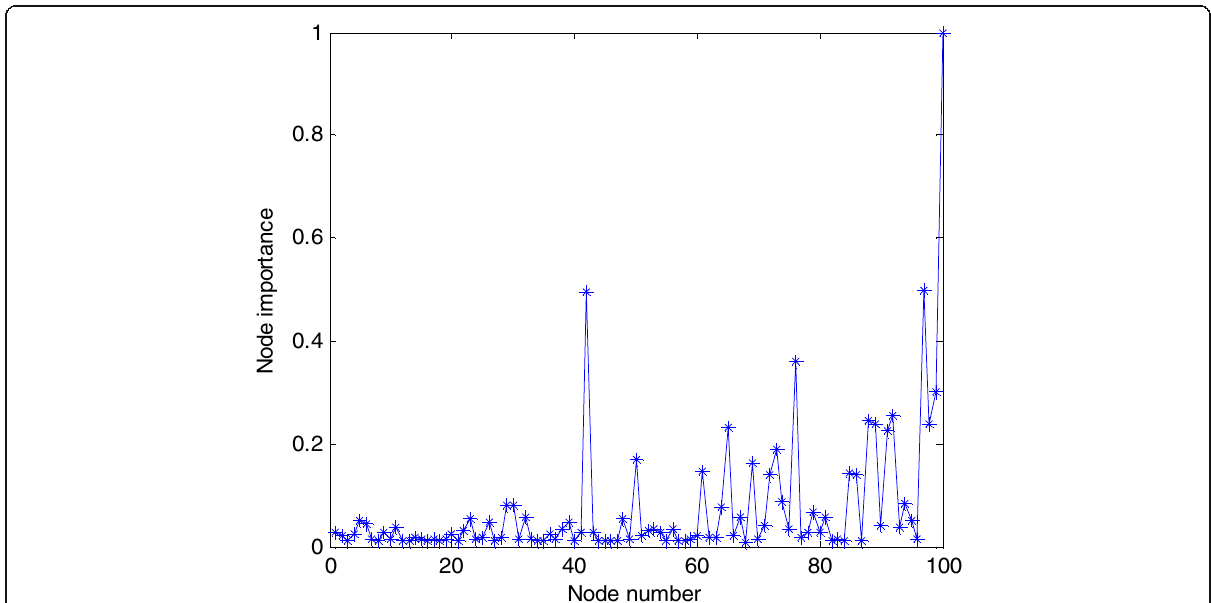
Fig. 4 Node importance of each node. The node importance results of BA scale-free network from Fig. 3 by using the MADME method